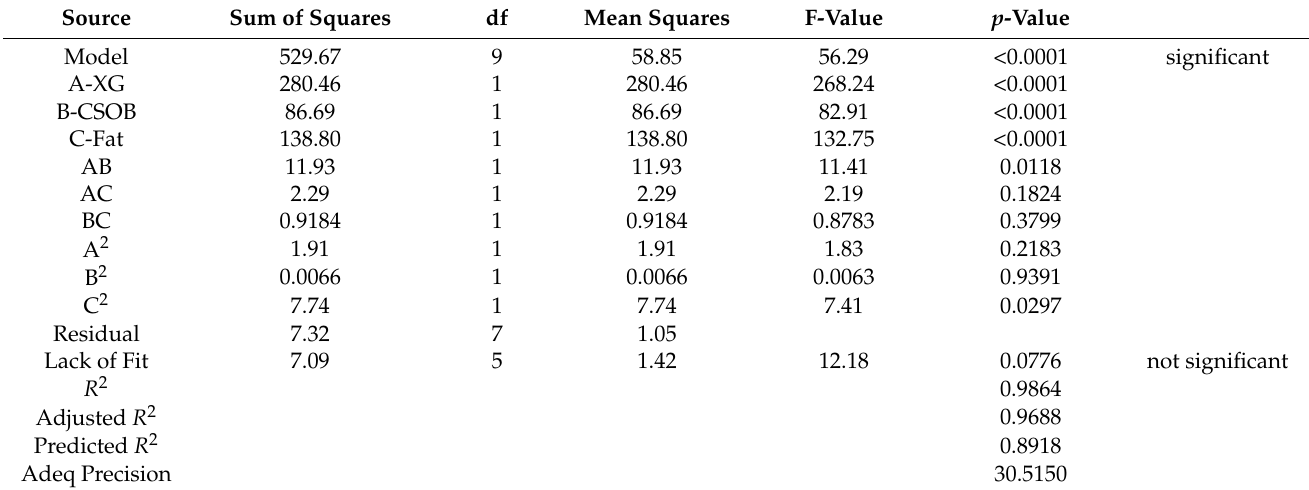
Table 2. Quadratic model parameter’s corresponding K